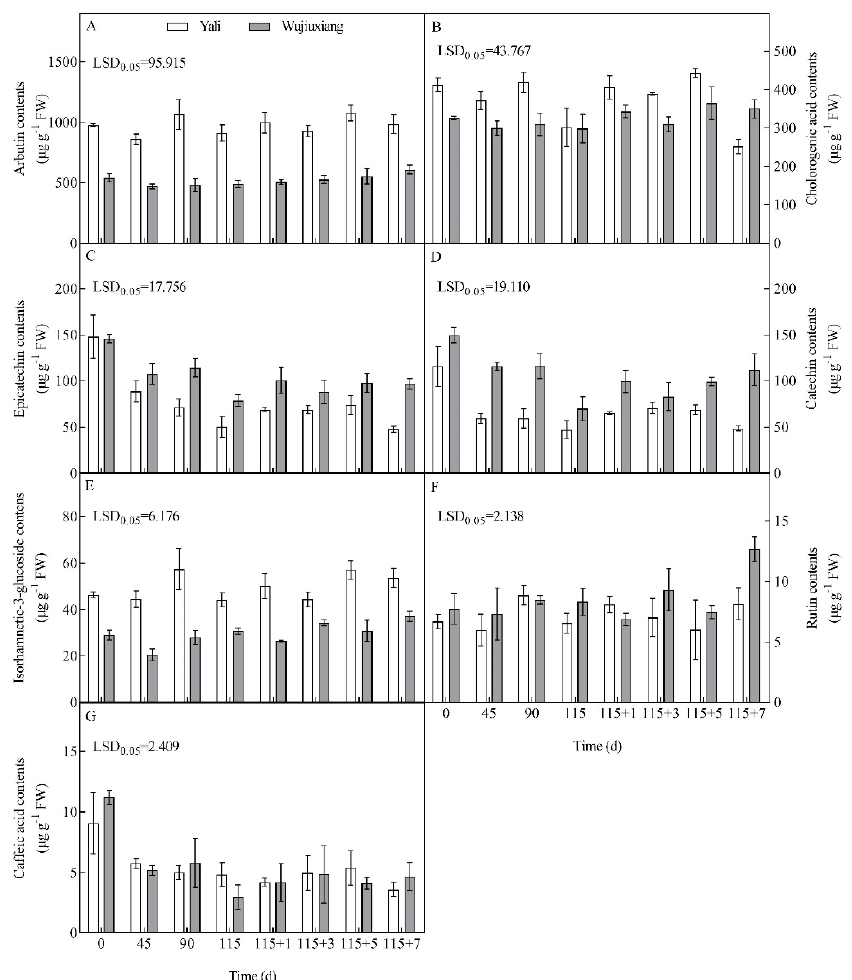
Figure 4. Contents of arbutin ( A ), chlorogenic acid ( B ), epicatechin ( C ), catechin ( D ), isorhamnetic-3-glucoside ( E ), rutin ( F ), and caffeic acid ( G ) in the peels of ‘Yali’ and ‘Wujiuxiang’ pears during cold storage and the shelf life. The vertical bar represents the standard error while the LSD values show significant differences at the 0.05 level. Note: 115 + 1, 115 + 3, 115 + 5, and 115 + 7 indicate 1, 3, 5, and 7 days of shelf life at room temperature (20 °C) after cold storage at 0 °C for 115 days.